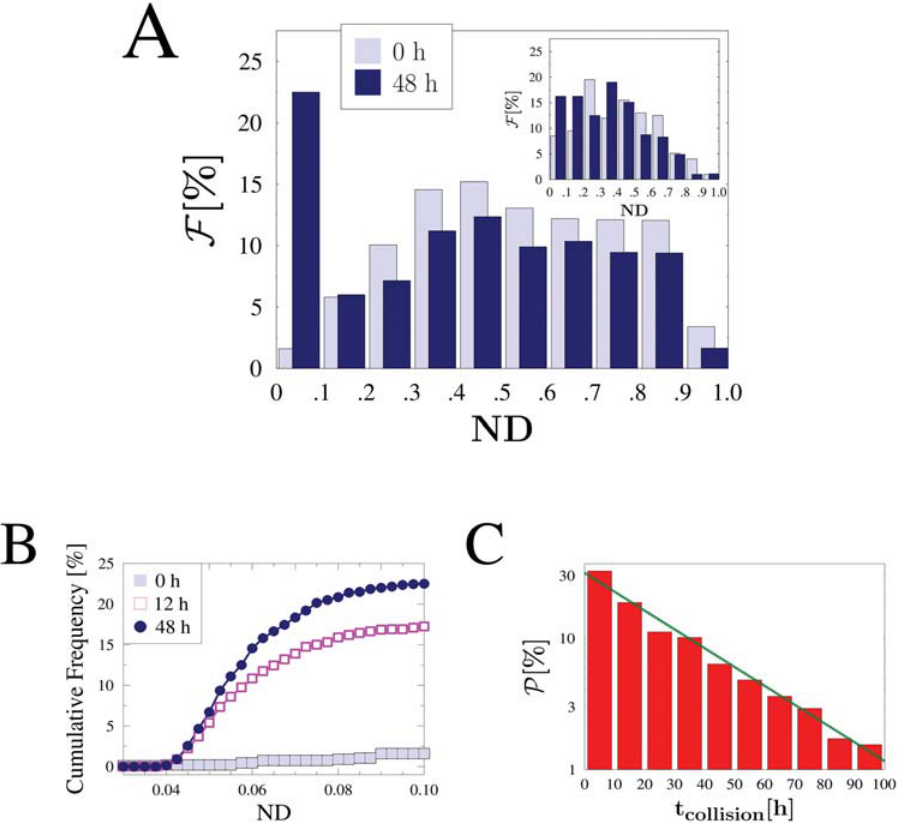
Figure 6. Distance and collision times distribution. (A) The distribution F of the normalized distance, ND (0 , ND # 1), between the two X chromosomes is plotted at two time frames (in the phase where pairing occurs, here c =5%, E =1 kT ). The initial distribution corresponds to randomly located chromosome positions ( t =0 h); while colocalization progresses a peak in F ND v 0 : 1 ð Þ becomes visible and saturates at 48 h. In the inset the corresponding experimental data (from [4]) are reported. (B) The cumulative frequency distribution of ‘paired chromosomes’(i.e., having ND , 0.1), under the same conditions of (A), is shown. (C) Probability distribution P of the time t collision required by a chromosome to encounter for the first time the other (i.e., to be located within a normalized distance, ND , less than 0.1 from it) with the same values for E and c used in (A) and (B). An exponential behaviour is found (superimposed fit).